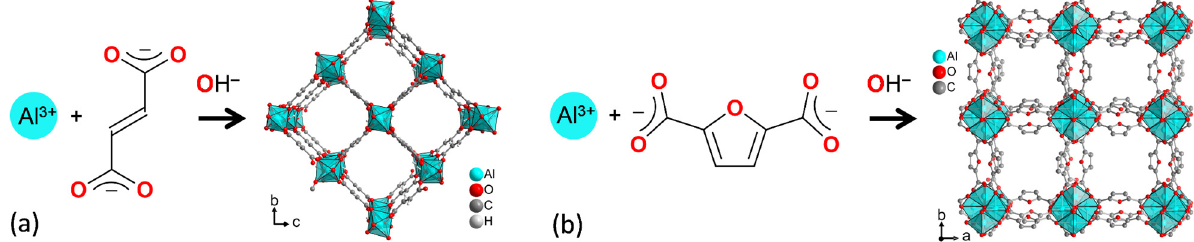
Figure 1. Schematic formation of ( a ) aluminum fumarate (Alfum) from Al 3+ and fumarate and ( b ) MIL-160 from Al 3+ and 2,5-furandicarboxylate (see Section S1, Figures S1 and S2, Supplementary Information for further details).